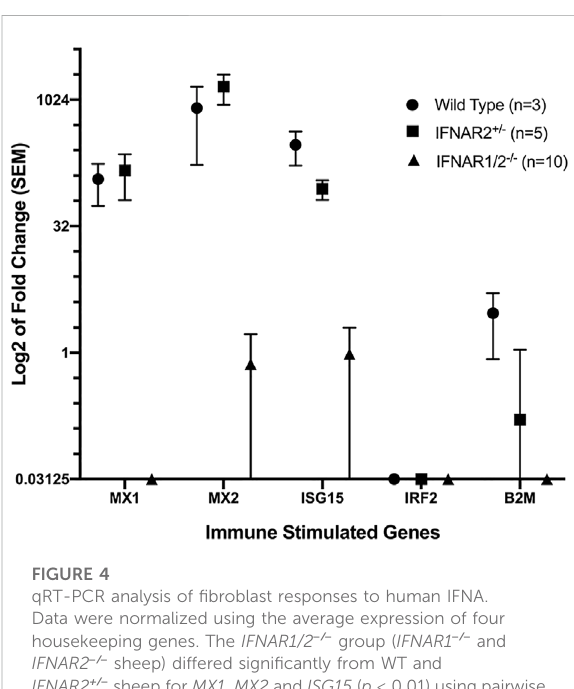
FIGURE 5 ComparisonofthereplicationkineticsofZIKVinSFFsisolated fromWTand IFNAR2 − / − sheep.Primary fi broblastsderivedfromWT and IFNAR2 − / − sheep fetuses were infected at a multiplicity of infection of one with each of the following three strains of ZIKV: MR-766, P6-740, and PRVABC-59. At the indicated time points after infection, cell culture supernatants were harvested to determine the yield of progeny virions using a standard plaque assay on Vero cells. The virus titers in plaque-forming units per ml (PFU/ml) are plotted as a line graph of the average with standard deviation of two replicates. Statistical comparisons were done using a two-tailed t -test at each time point for each viral strain produced from WT and IFNAR2 − / − fi broblasts. p -values are color- coded: green (MR-766), orange (P6-740), and red